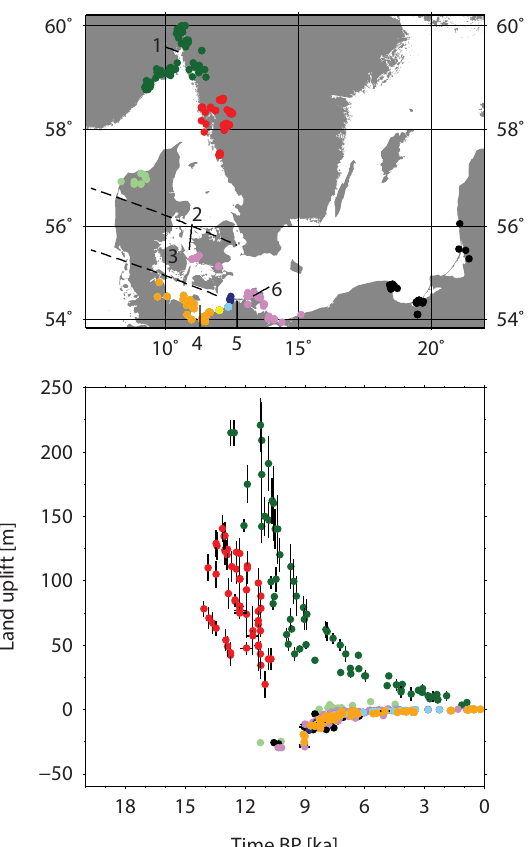
Figure 1. Spatial and temporal distribution of relative sea-level data used in this study. Colours indicate five regional subsets: (I) South- west Sweden (red), (II) Oslo Graben (dark and light green for Oslo Fjord and Limfjord, respectively), (III) Fyn with Great Belt, Rügen, Usedom (violet), Darss Peninsula (dark blue) and Körkwitz (light blue), (IV) bays of Kiel and Lübeck (orange) and Rostock (yellow), (V) Poland and Lithuania (black). Data uncertainties are indicated by vertical error bars. Geographical information: 1 Oslo Fjord; 2 Great Belt; 3 Fyn; 4 Bay of Lübeck; 5 Darss Peninsula; 6 Rügen. Dashed lines mark the location of the Rinkøping-Fyn